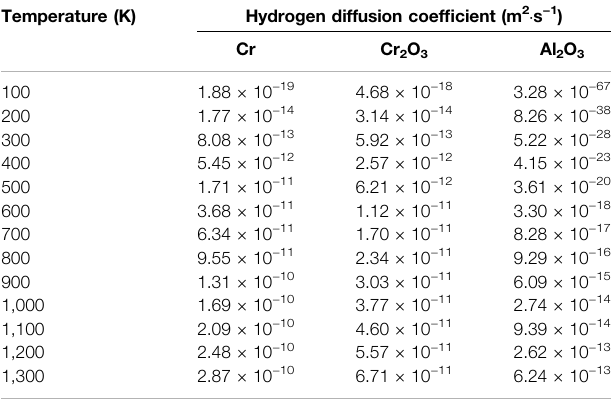
TABLE 5 | Hydrogen diffusion coef fi cient of three types of coatings.